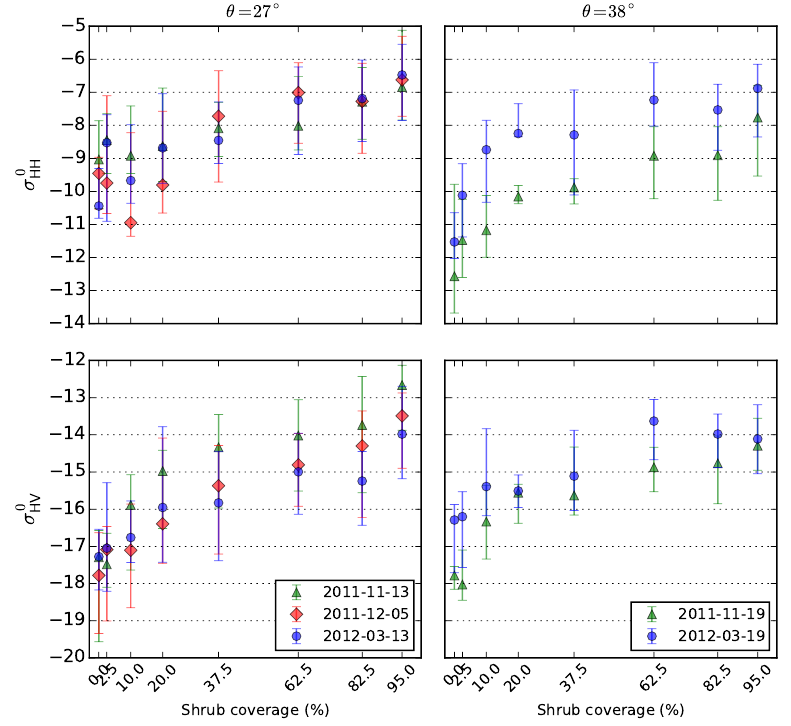
Figure 7. TerraSAR-X backscattering response to shrub coverage comparing November, December and March acquisitions; the left column displays incidence angle θ = 27 ◦ and the right column θ = 38 ◦ . The markers represent the median values and the error bars the lower and upper